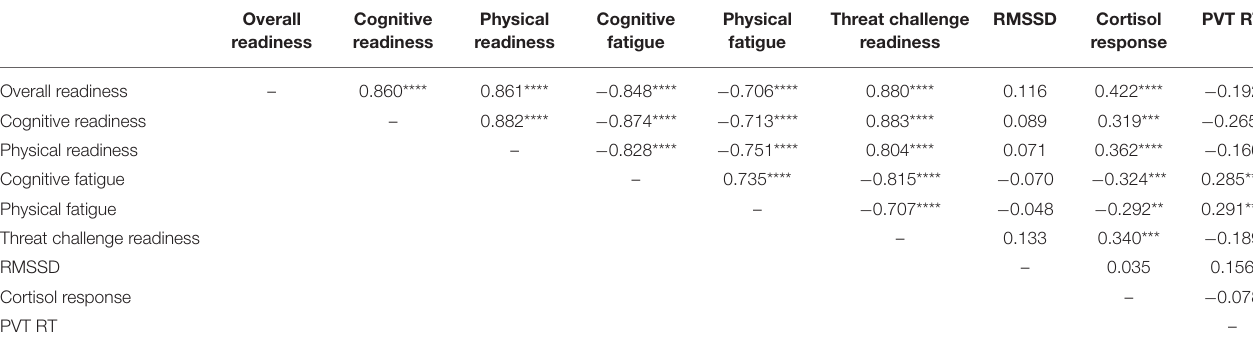
TABLE 2 | Repeated measures correlations between all variables, including each subscale of the ARMS, heart rate variability, cortisol, and cognitive performance.